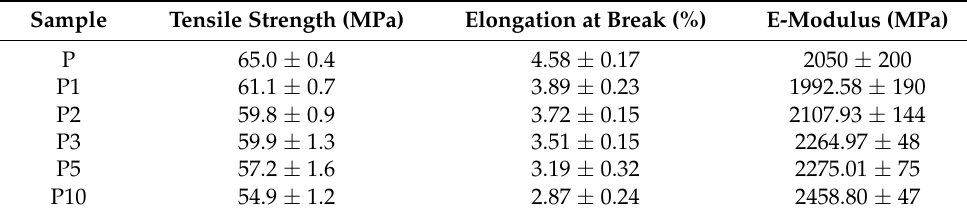
Table 1. Mechanical properties polylactide (PLA) and biocomposites.